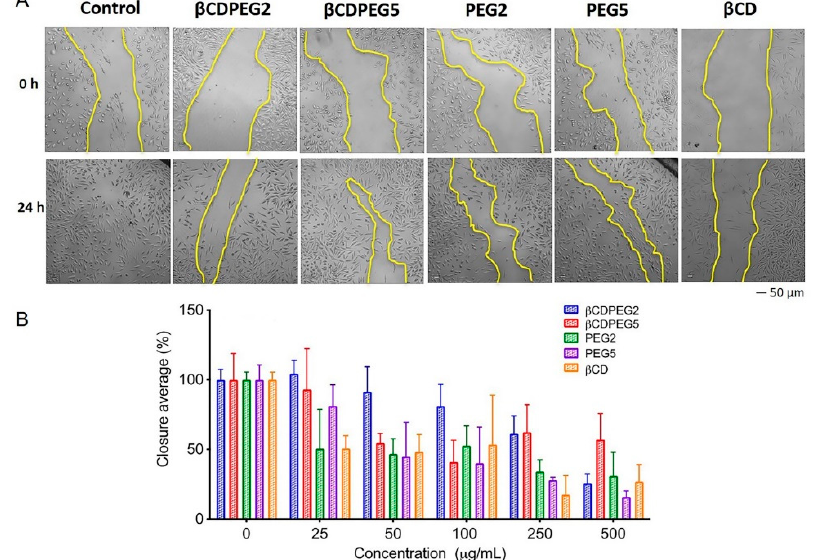
Figure 5. MC3T3-E1 osteoblast migration in the presence of β CDPEGs, β CD, and PEGs. A scratch was made through the MC3T3-E1 cell layer, and then cells were cultured in the presence of different concentrations of β CDPEGs, β CD, and PEGs (25, 50, 100, 250 and 500 µg/mL) for 24 h. ( A ) Repre- sentative images of migration assay of the compounds at 500 µg/mL after the scratch (0 h) and at 24 h later, showing the gap closure (area between the two yellow lines). The images were captured at the same scale with a scale bar of 50 µm. ( B ) Area between the two dotted lines expressed as the percentage of cell closure relative to the control.